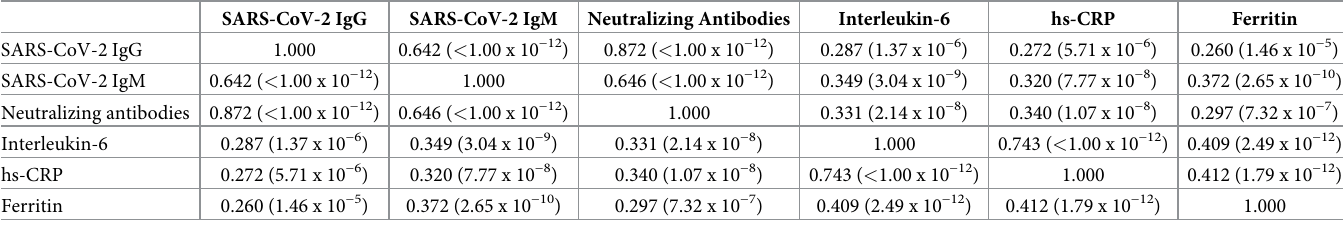
Table 2. Spearman correlation coefficient matrix analysis of antibody and inflammatory marker response in all subjects (N = 278).